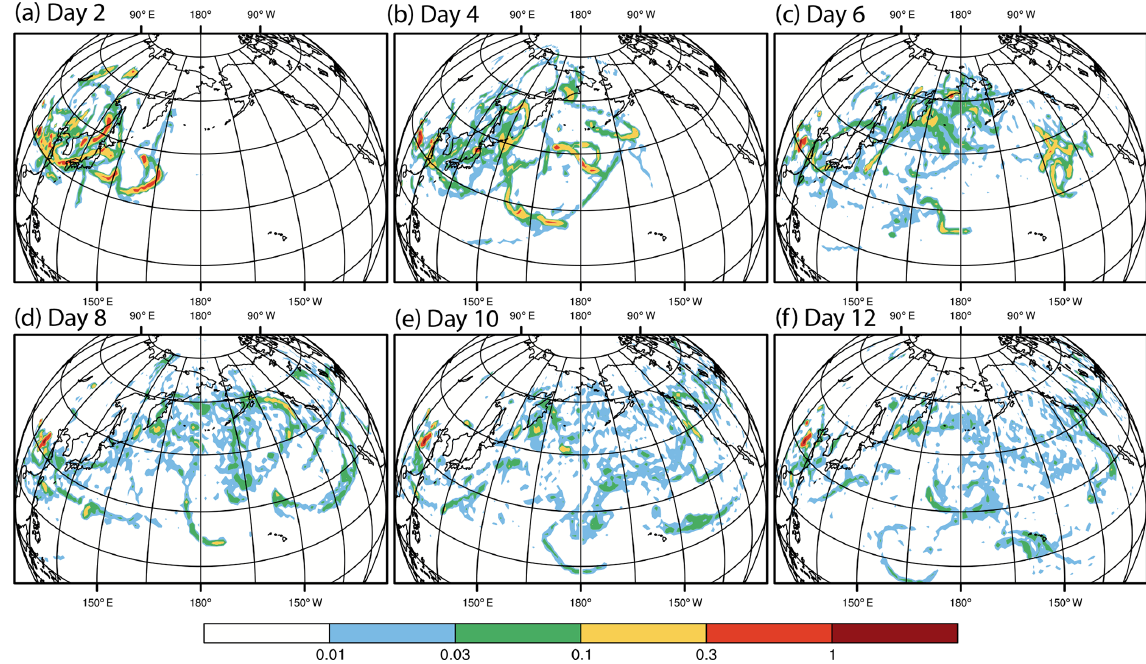
Figure 7. Spatial distribution (%) of trajectory endpoints by the end of days (a) 2, (b) 4, (c) 6, (d) 8, (e) 10, and (f) 12 after emission from the central Gobi Desert during